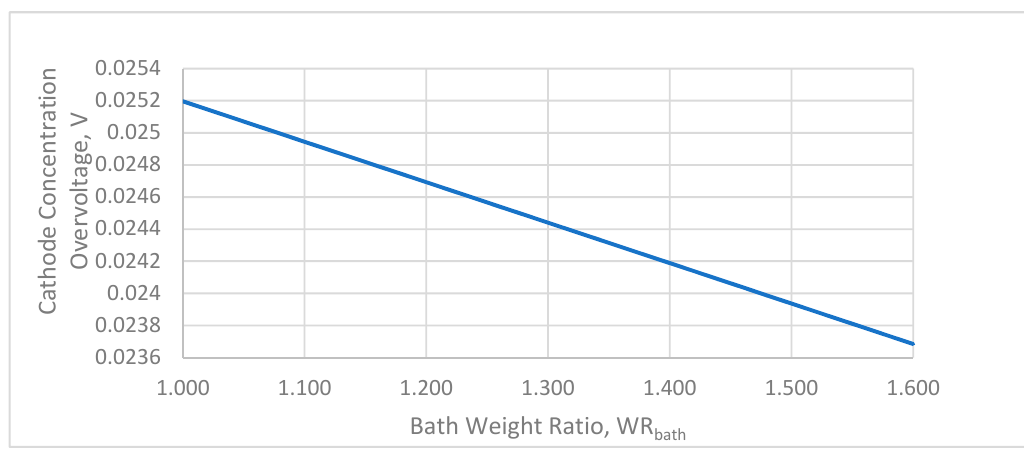
Figure 5. The effect of the bath ratio on the anode concentration overvoltage.